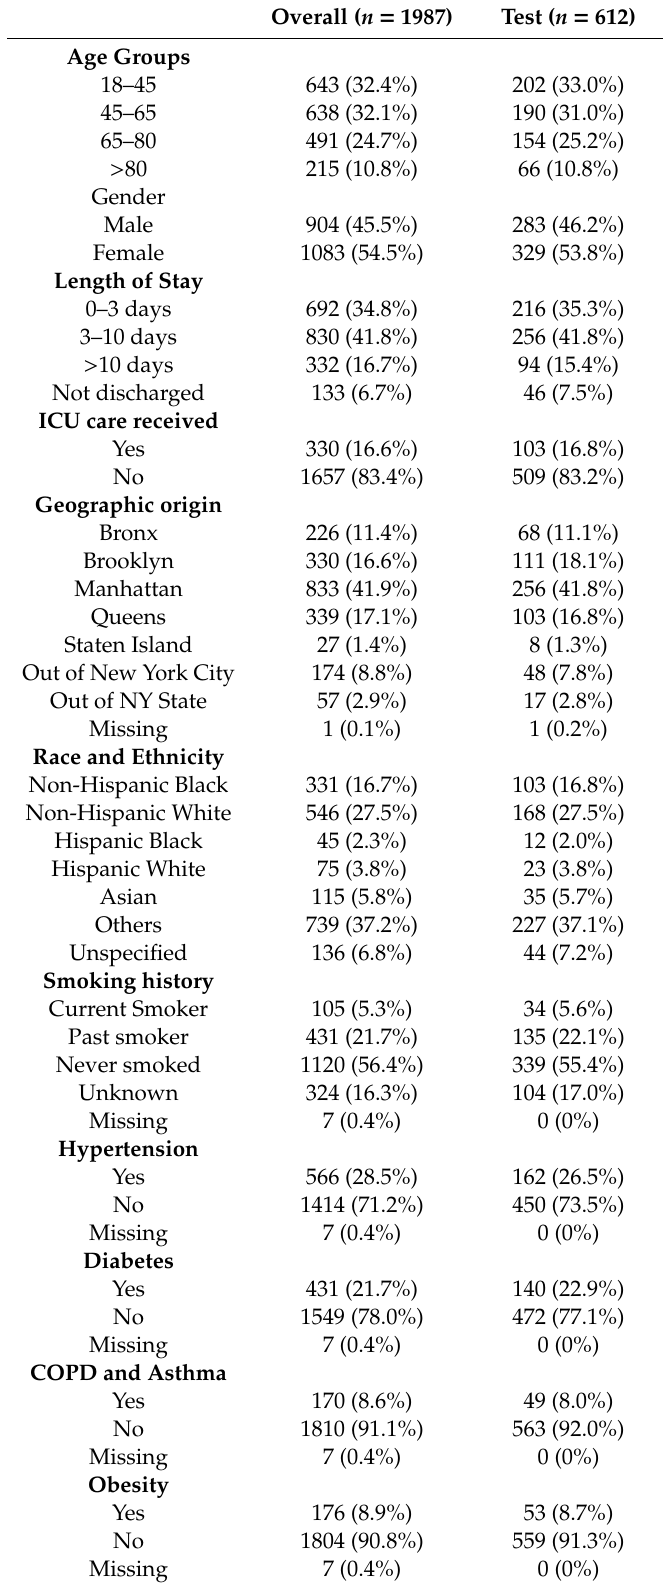
Table 1. Patient characteristics in the overall study cohort and test